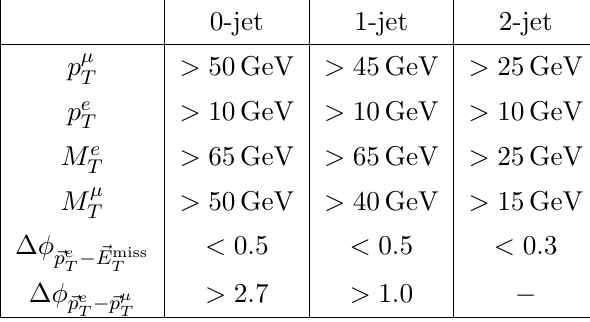
is de(cid:12)ned T